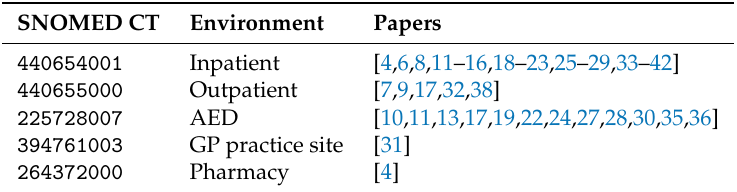
Table 4. Papers with their corresponding SNOMED CT encounter